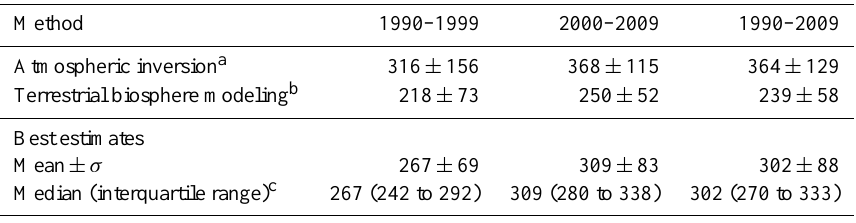
Table 2. Interannual variability of annual net land–atmosphere exchange of CO 2 -C (TgCyr − 1 ) for North America by decade and for the